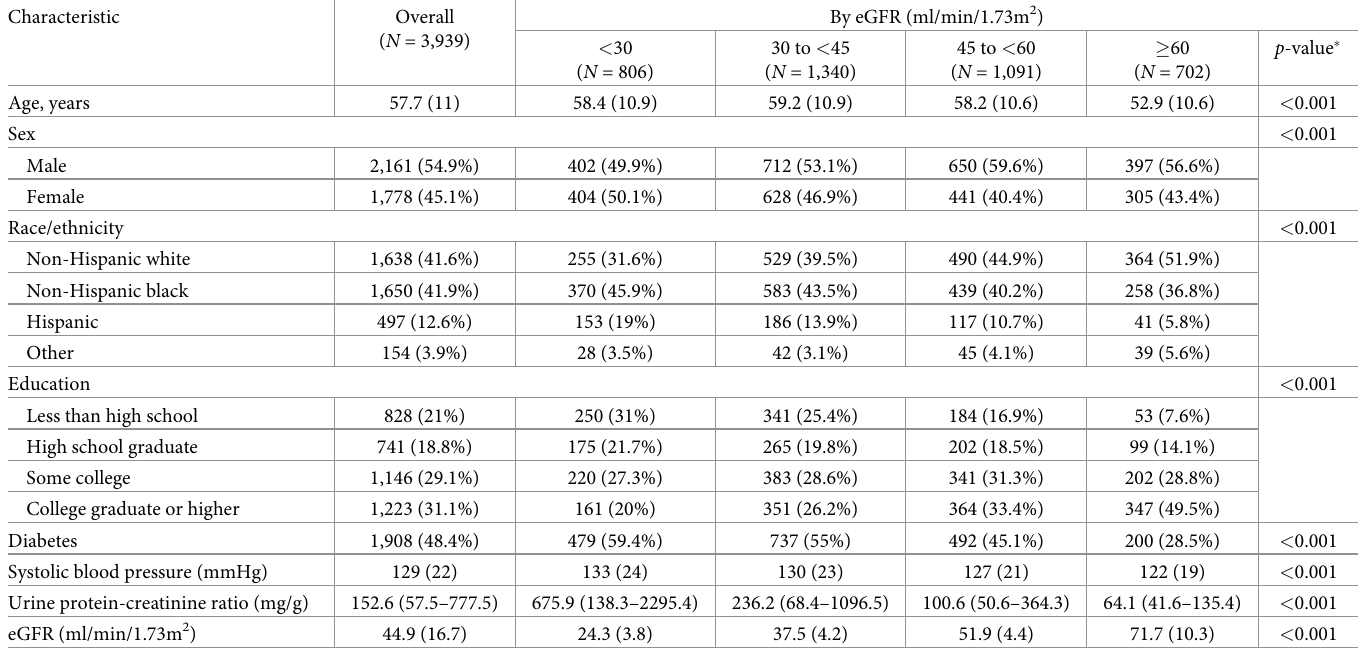
For categorical variables, reported as number (%, percentage), and for continuous variables, mean and standard deviation is reported if normally distributed and mean and interquartile range if not normally distributed.